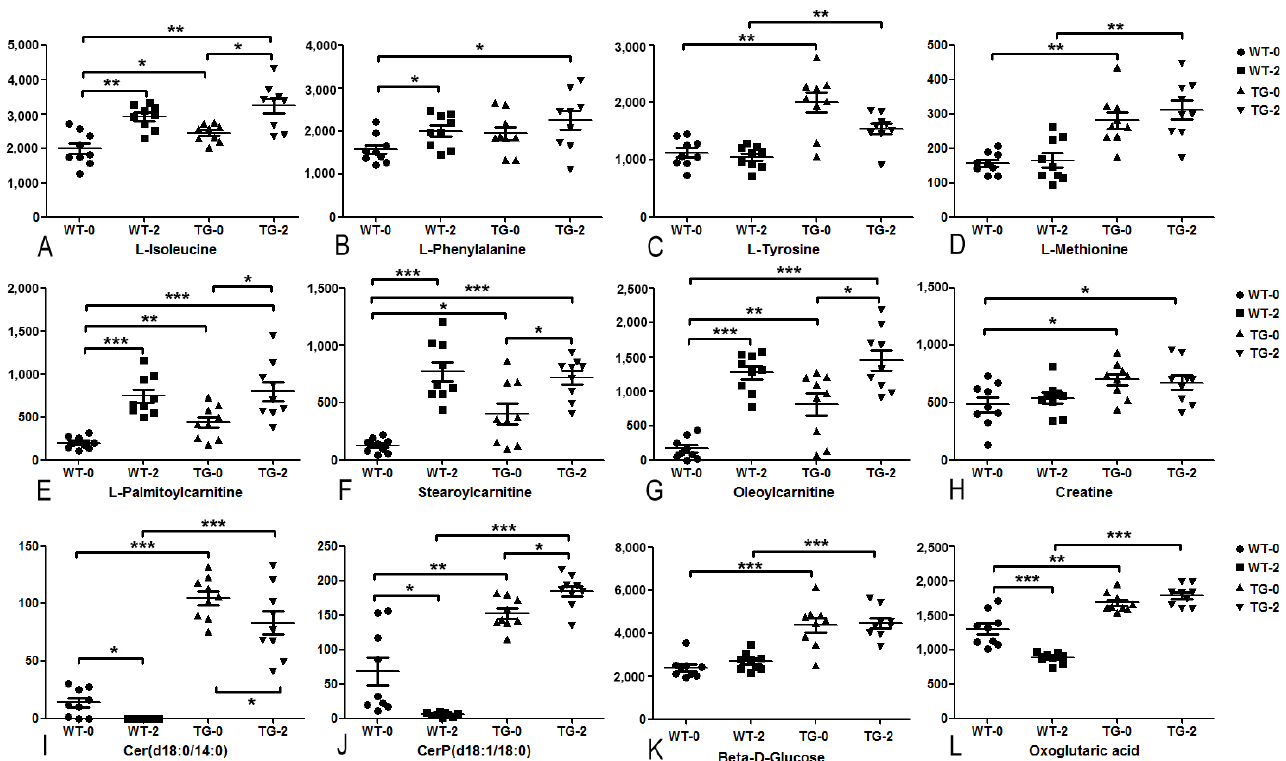
Figure 5. The abundance of commonly accepted biomarkers for diabetes and/or obesity-related disease in the four groups of pig plasma samples. ( A – D , H ) for amino acids, ( E – G ) for acylcarnitines, ( I , J ) for ceramides, ( K ) for glucose, ( L ) for oxoglutaric acid. * adj. p < 0.05, ** adj. p < 0.01, *** adj. p < 0.001.